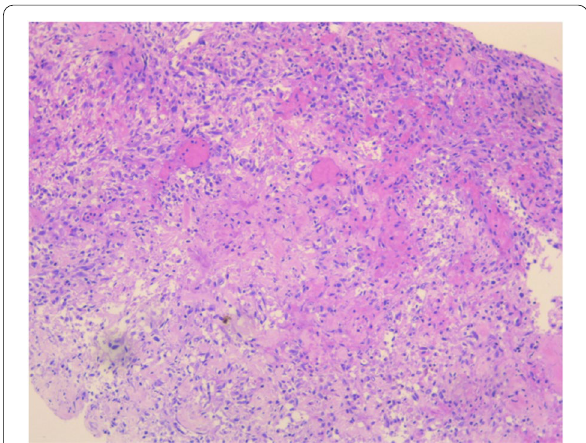
Fig. 3 Moderately pleomorphic spindle cells arranged in storiform and fascicles with area of necrosis ( haematoxylin eosin (H&E)